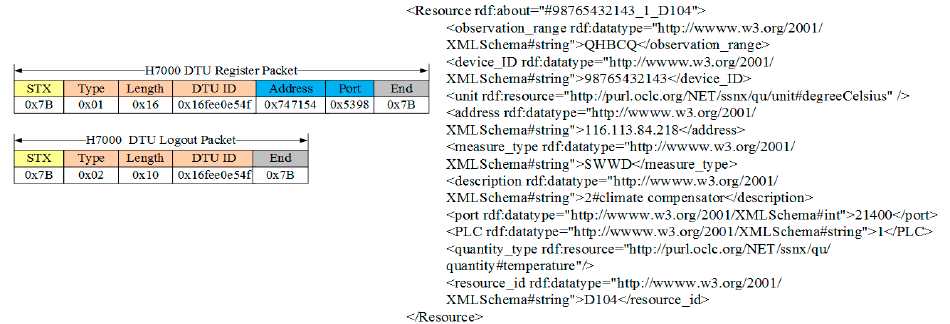
Figure 10. The process of device accessing and resource description.